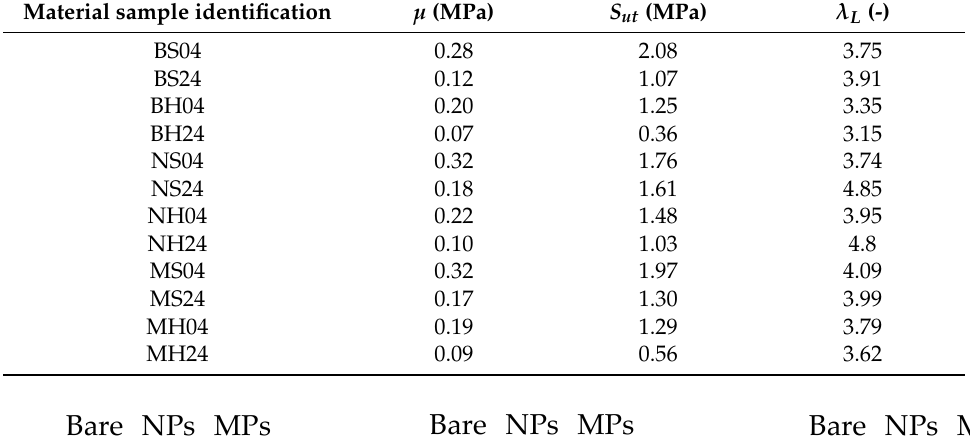
-80-70-60-50-40-30-20-10